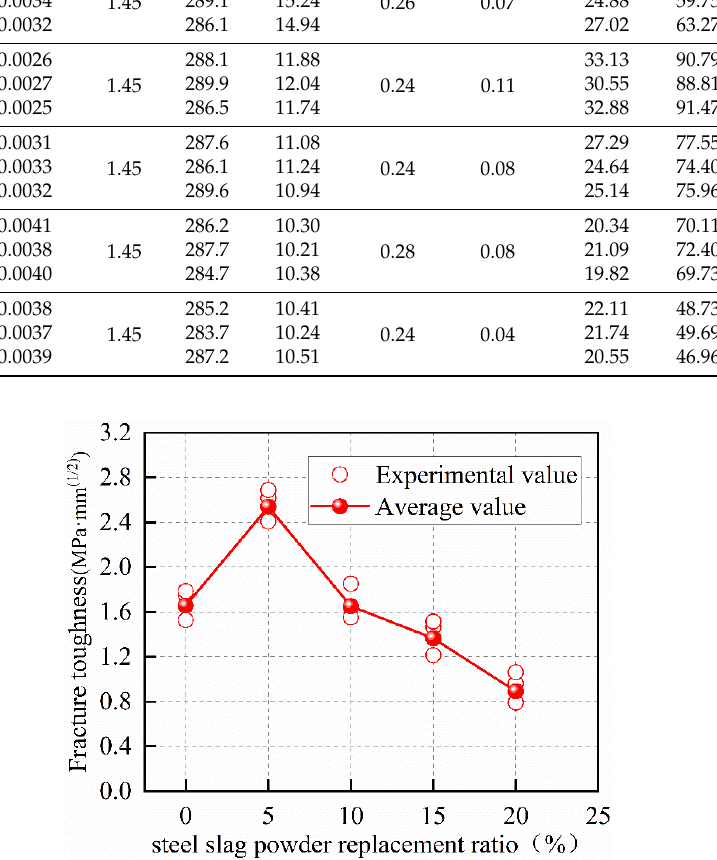
Figure 8. Fracture toughness of concrete at different steel-slag-powder replacement ratios.